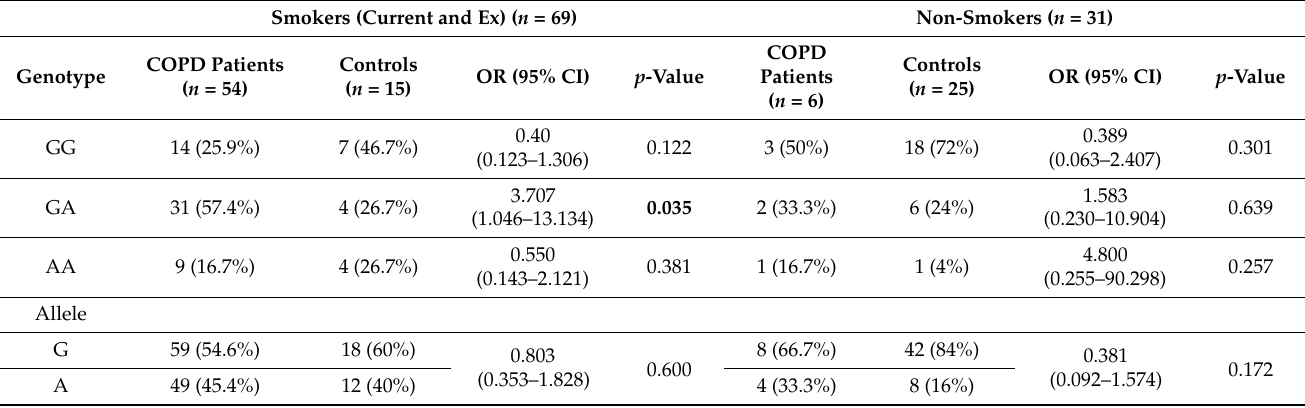
Table 4. Genotype and allele frequencies of RAGE rs2070600 gene polymorphism in COPD patients and controls and corresponding ORs for COPD by smoking